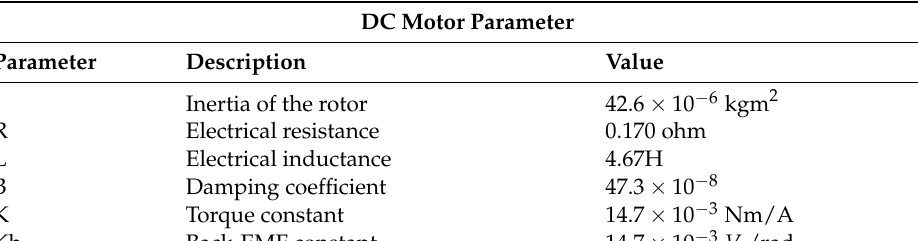
Table 2. Numerical values for the state space equation of DC motor.